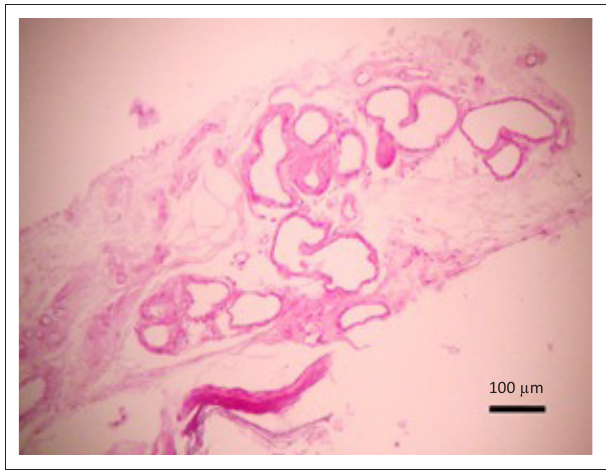
H&E, Haematoxylin and eosin stain. FIGURE 2: The cyst was lined with stratified squamous epithelium and filled with desquamated keratin.